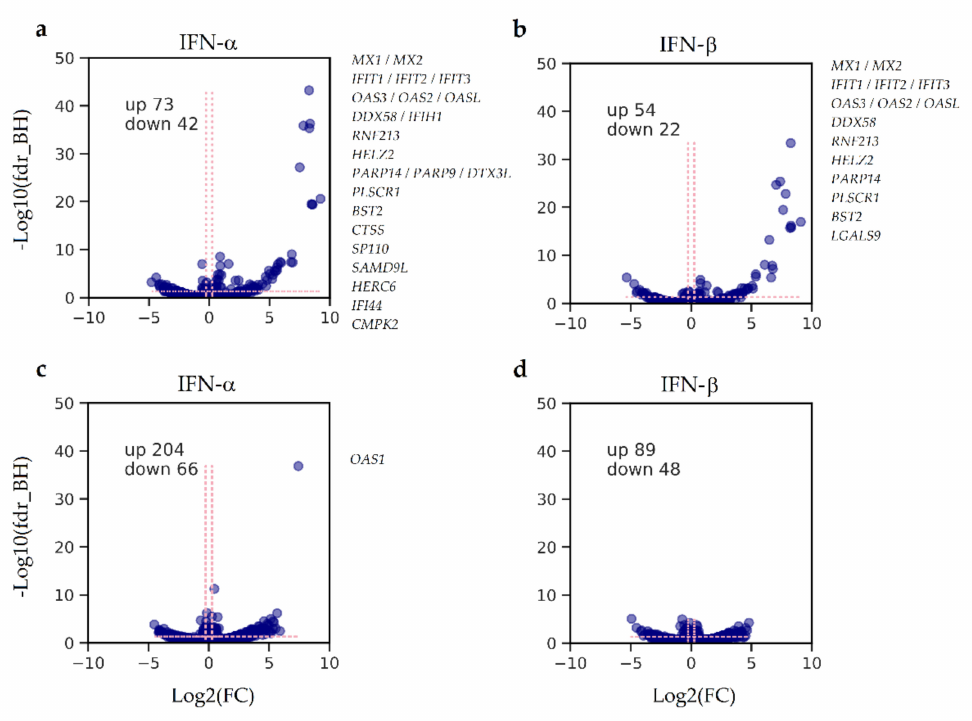
Figure 2. Alterations in GBM cells’ proteomes depending on the status of type I IFN signaling and IFN subtype used: ( a , b ) cohort with preserved antiviral protection by type I IFNs; ( c , d ) cohort with defective antiviral protection by type I IFNs. The genes named by plots correspond to the proteins altered as strong as log 2 (fold_change) > 5.0, with statistical significance as high as -log 10 (fdr_BH) > 5.0. Dashed lines correspond to statistical (fdr_BH < 0.05) and fold change (|log 2 FC| ≥ 0.263) thresholds used for the determination of up and downregulated proteins. NSAF used for missing value imputation MV = min(NSAFs) · 10 − 3